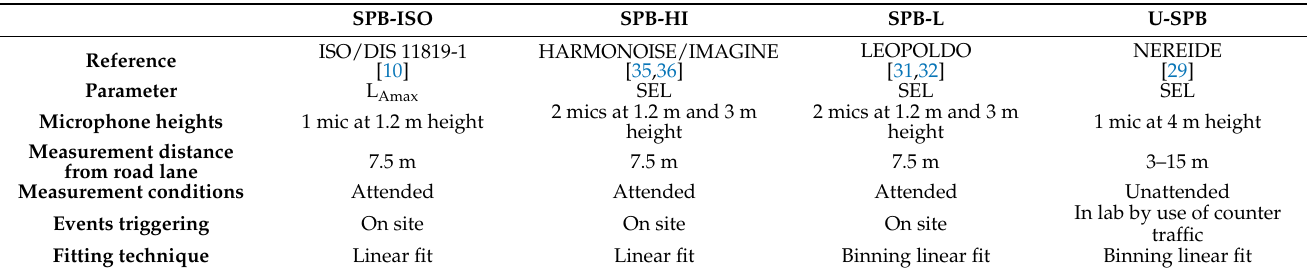
Table 1. Summary of SPB method adaptations mentioned in the paper and their